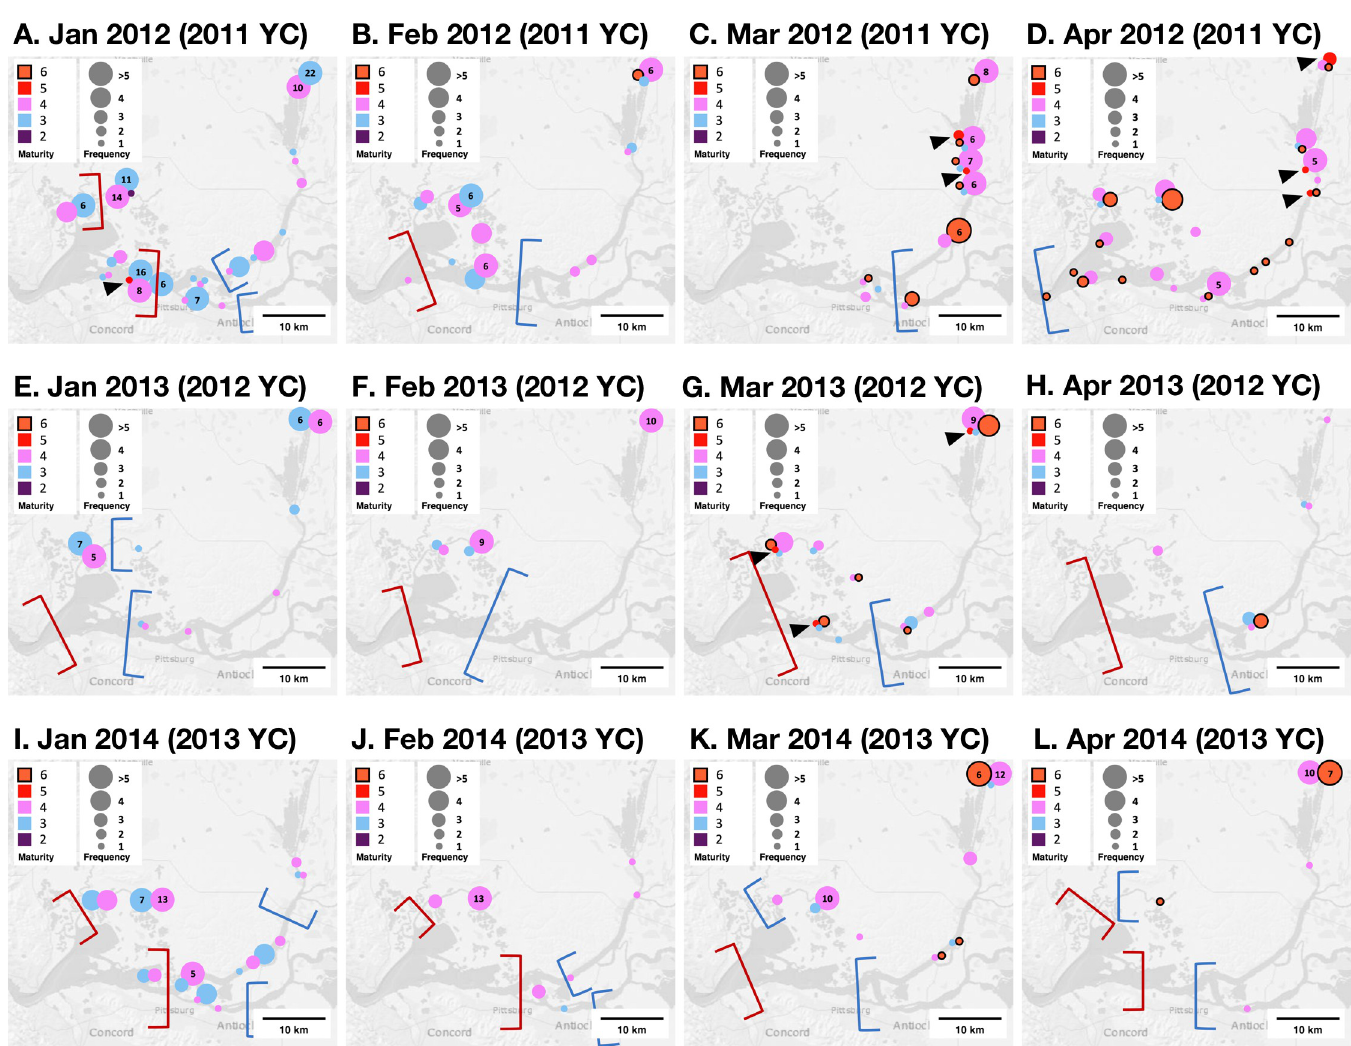
Fig 3. Maturity and distribution pattern of female Delta Smelt, 2011 (January-April 2012, Panels A-D), 2012 (January-April 2013, Panels E-H), and 2013 year-classes (YC) (January-April 2014, Panels I-L). Fish at the final hydration stage (Stage 5) are indicated by arrow heads. The blue and red brackets indicate a simplified salinity boundary for 1.0 and 6.0, respectively. The data from May were not included due to the very small sample numbers. The field sampling was not performed in the Grizzly/ Suisun Bay in March 2012 (Panel C, S1 Table). The data for the 2014 year-class can be found in S3 Fig. The base map was downloaded from the U.S. Geological Survey